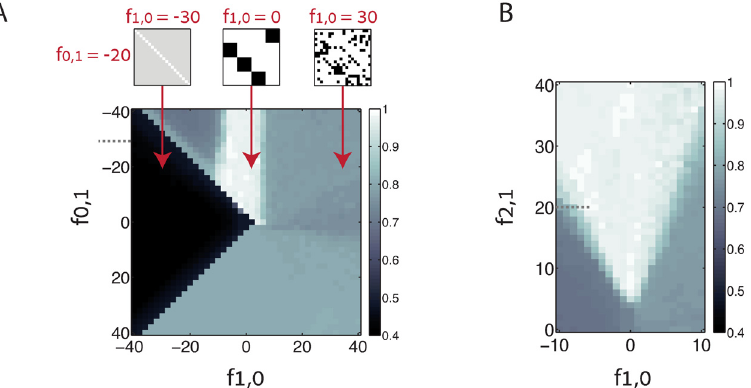
Fig 6. Chain score of the steady state connectivity, obtained from simulations that include selected motifs. A. Density plot of the chain score, displayed as a function of the motif coefficients f 1,0 (horizontal axis) and f 0,1 (vertical axis). All other motif coefficients are kept fixed. Note that here f 2,1 = 20 (designated by a dotted line in panel B). Above: examples of steady state connectivity matrices for f 0,1 = − 20, and (from left to right) f 1,0 = − 30, 0, 30. B. Chain score as a function of the motif coefficients f 1,0 (horizontal axis) and f 2,1 (vertical axis) with all other motif coefficients kept fixed. Here f 0,1 = − 30 (designated by a dotted line in panel A). Each data point represents an average over ten simulations, each with a different realization of the initial random connectivity. Additional details of the plasticity dynamics are specified in